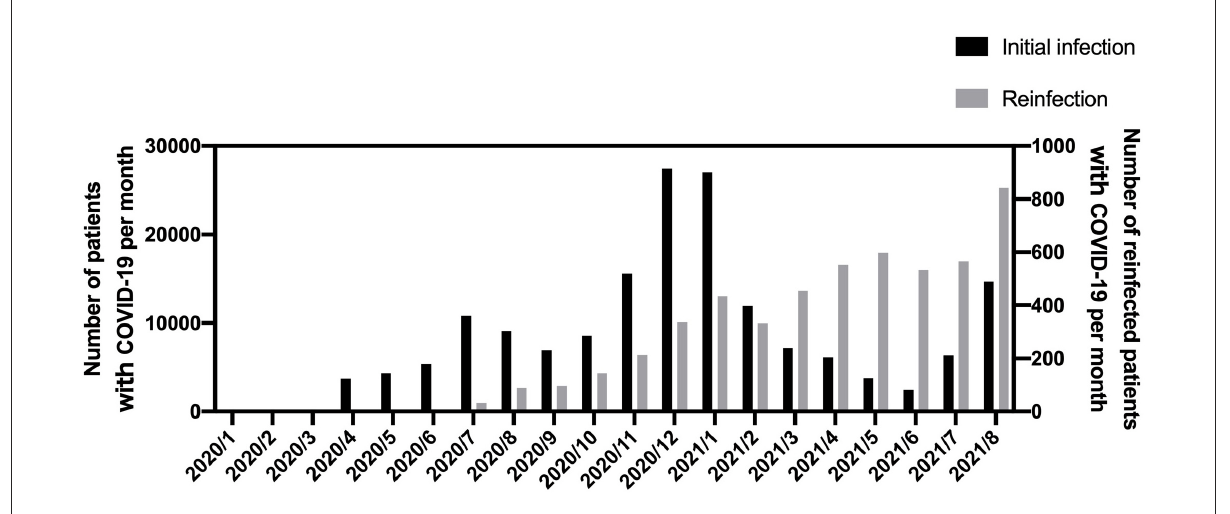
FIGURE1 Number of infected and reinfected patients per month in this study. COVID-19, coronavirus disease